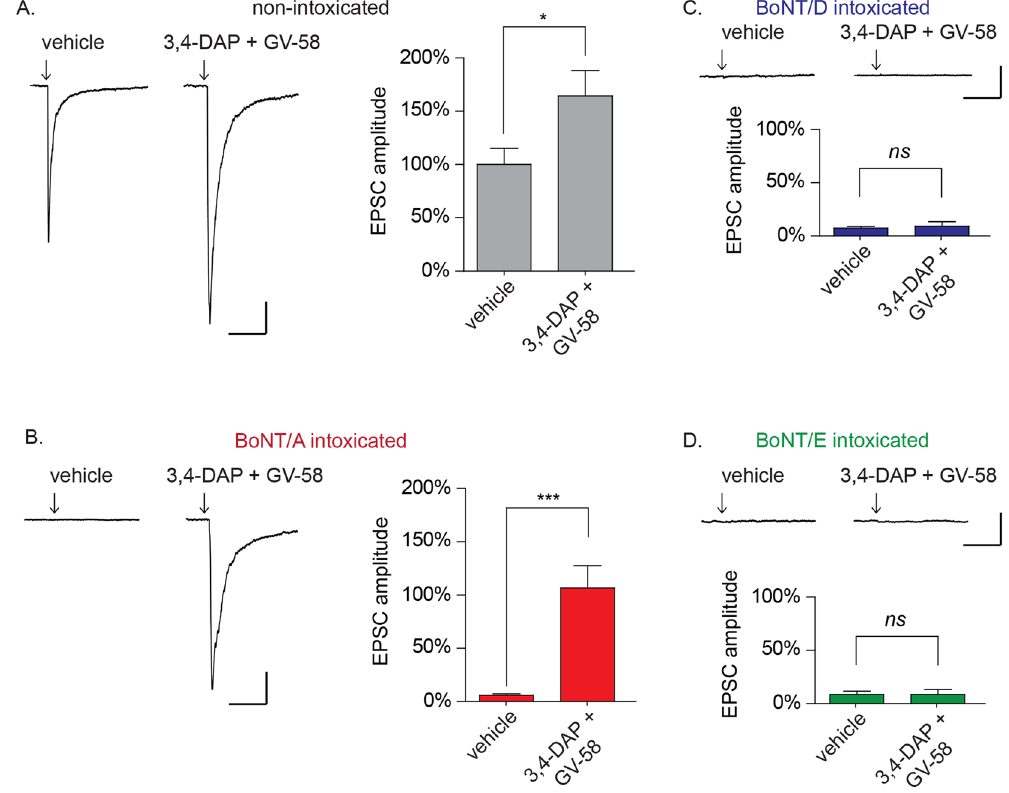
Figure 5. 3,4-DAP plus GV-58 restores evoked neurotransmission to baseline levels in cultured neurons intoxicated by BoNT/A, but not BoNT/D or BoNT/E. Representative EPSC and mean EPSC amplitudes from cultures intoxicated with: ( A ) vehicle; ( B ) BoNT/A; ( C ) BoNT/D; or ( D ) BoNT/E. Arrows represent stimulation times. Scale bars represent 400 ms (x-axis) and 100 pA (y-axis). Mean EPSC amplitudes are presented as mean ± SEM; n ≥ 13 recordings for 5A-B and n ≥ 9 recordings for 5C–D. * Indicates p < 0.05, *** Indicates p < 0.001, ns = not significant.